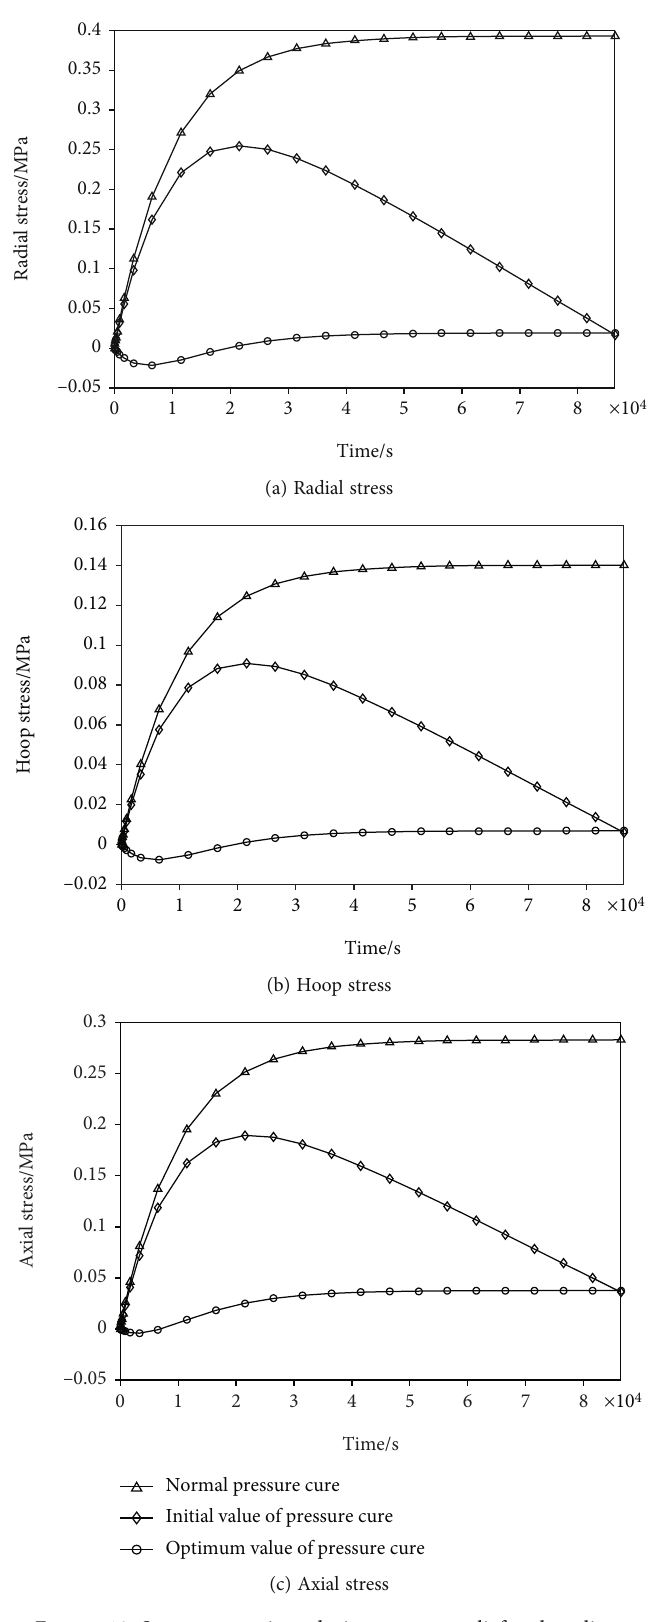
Figure 13: Stress comparison during pressure relief and